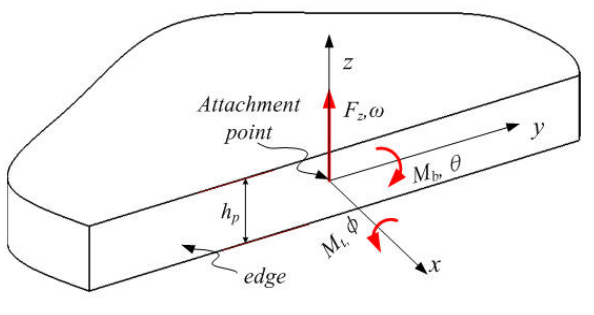
Figure 4. Semi-infinite plate and the applied loads to attachment point.